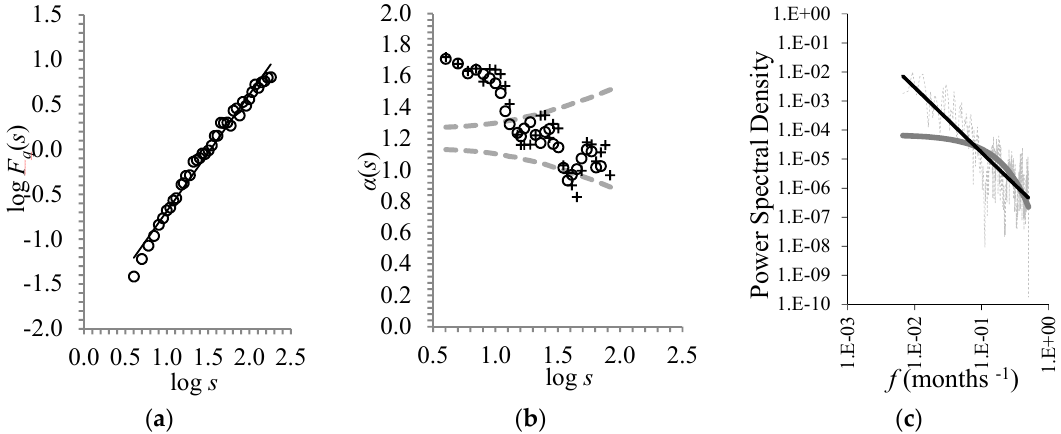
Figure 2. ( a ) The root-mean-square fluctuation function F d ( s ) of the CST time-series as a function of time scale s (in years). The corresponding best fit equation is y = 1.30x − 1.99 ( R ² = 0.98). ( b ) The variability of the power-law exponent expressed as local slopes of the log F d ( s ) vs. log s calculated within a window of 12 points (circles) and 10 points (crosses). The dashed grey line represents the 2 s a intervals around the local slopes with an average value of 𝑎 ̅ = 1.2. ( c ) The power spectral density as a function of frequency (a) (dashed gray line) with a power-law fit (black line) ( y = 1·10 − 7 ·x − 2.24 with R ² = 0.56) and the exponential fit (grey line) ( y = 7·10 − 5 ·e –11.5x with R ² = 0.39).